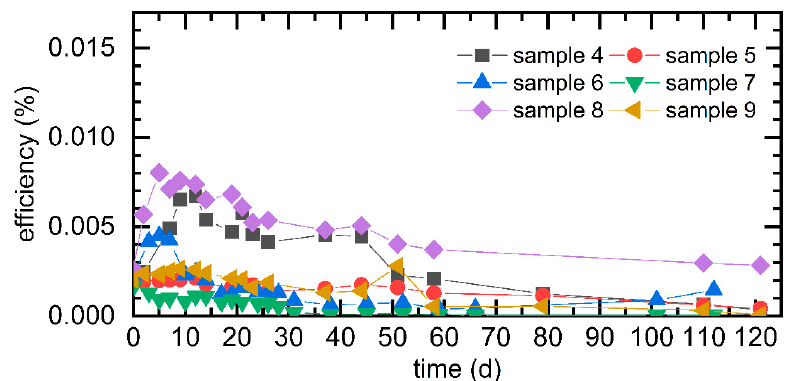
Figure 4. Efficiencies of ABS blended with PEO (sample 4), ABS (sample 5), PVA blended with PEO (sample 6), PVA (sample 7) and PVDF blended with PEO (sample 8) and PVDF (sample 9) GPEs for 120 days.